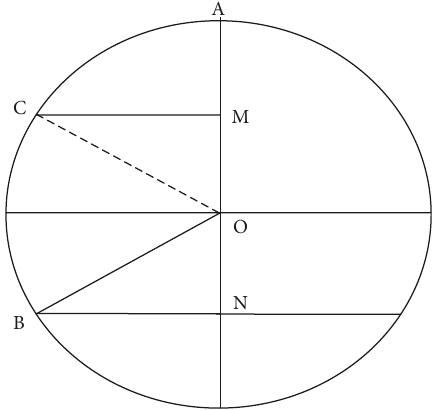
Figure 1: Positive value of point B is the line segment 2.